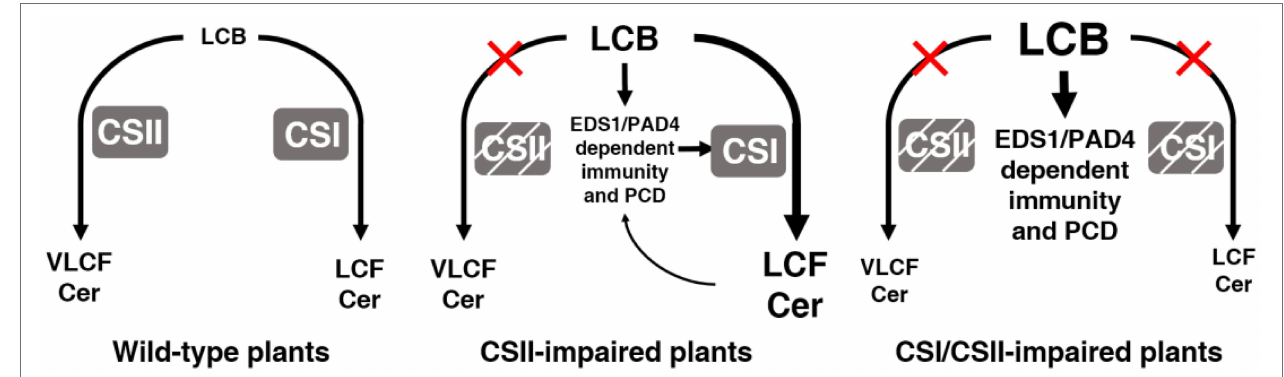
FIGURE 8 | The roles of Cers in plant immunity and cell death. Model summarizing the roles of CSI and CSII in immunity and cell death. In wild type, normal levels of LCBs are maintained by the action of CSI and CSII. With the loss of CSII, LCBs accumulate, and EDS1/PAD4 act downstream to trigger immunity and cell death, while CSI partially compensates for the loss of CSII by consuming LCBs. With the loss of both CSI and CSII, higher levels of LCBs result in stronger